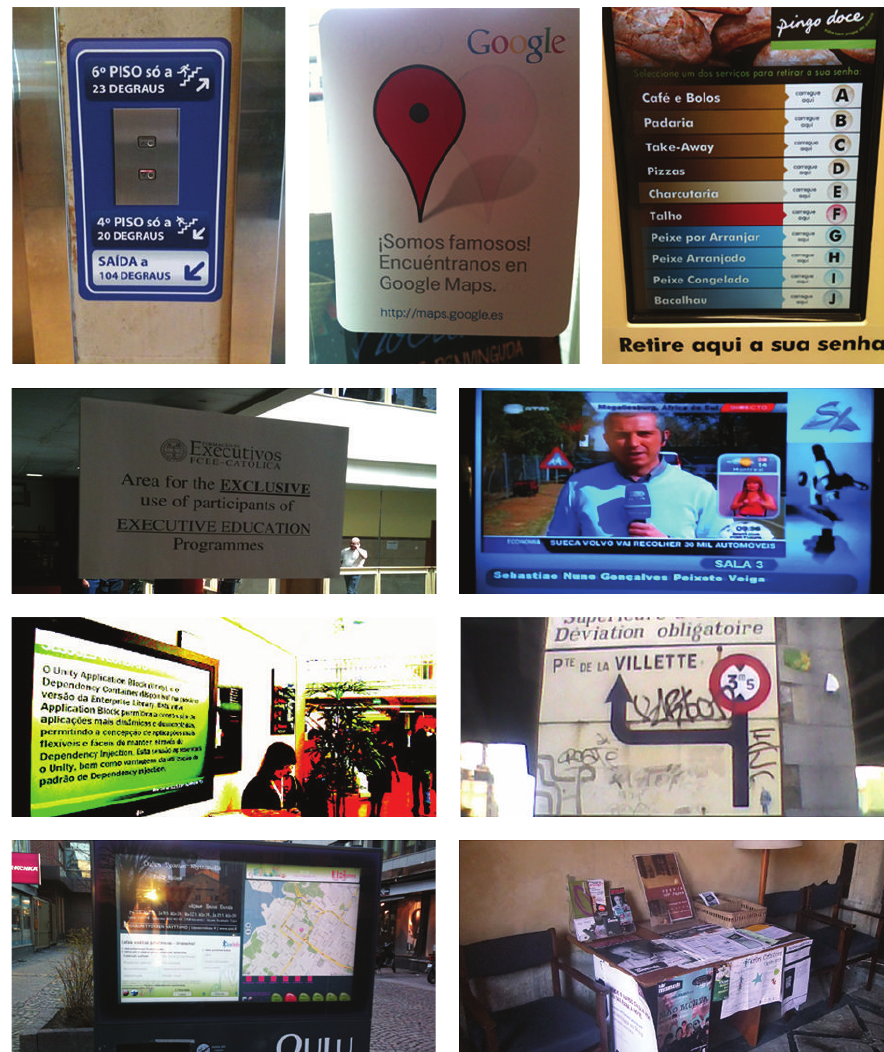
Figure 1: Examples of photos used in the